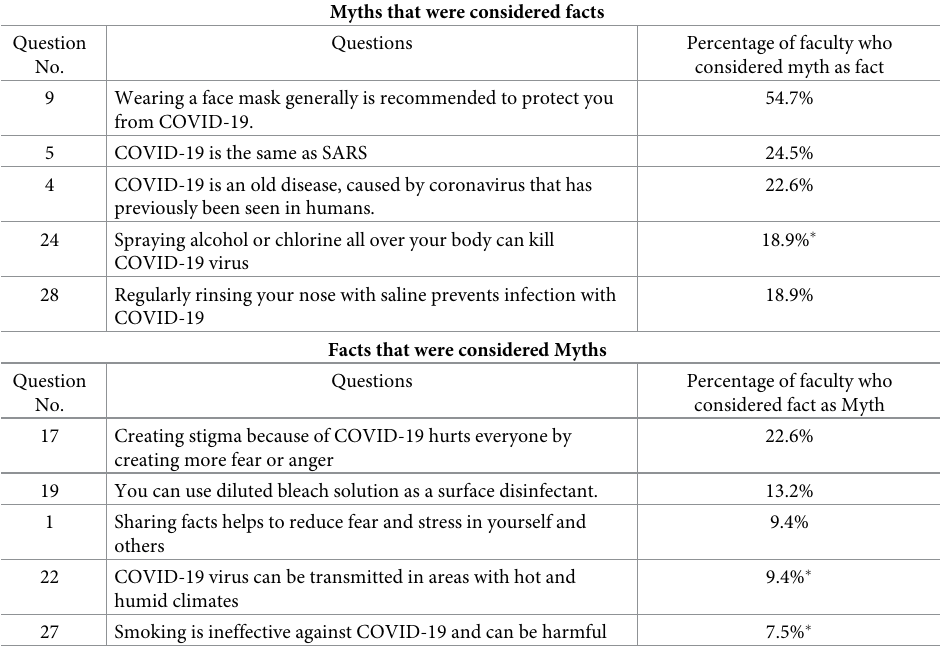
Table 4. Top five Myths that were considered facts and vice versa by faculty